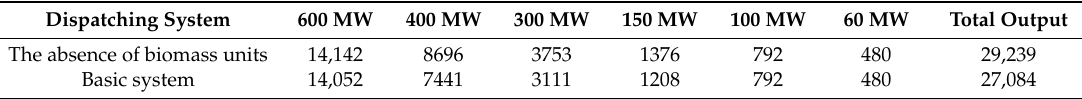
Table 7. The comparative results of power output structure of thermal power units (MW · h).